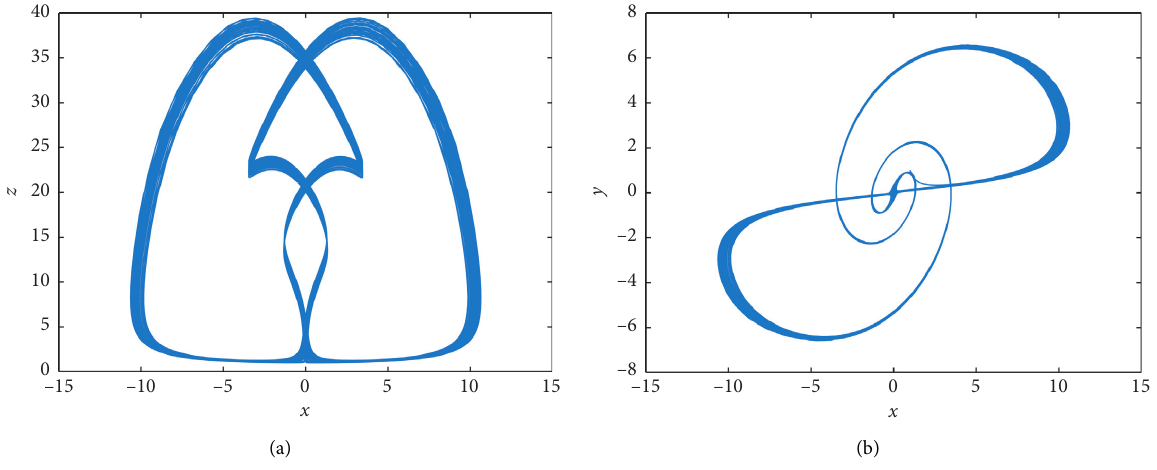
Figure 4: Phase portraits of the fractional system with α � 0 .